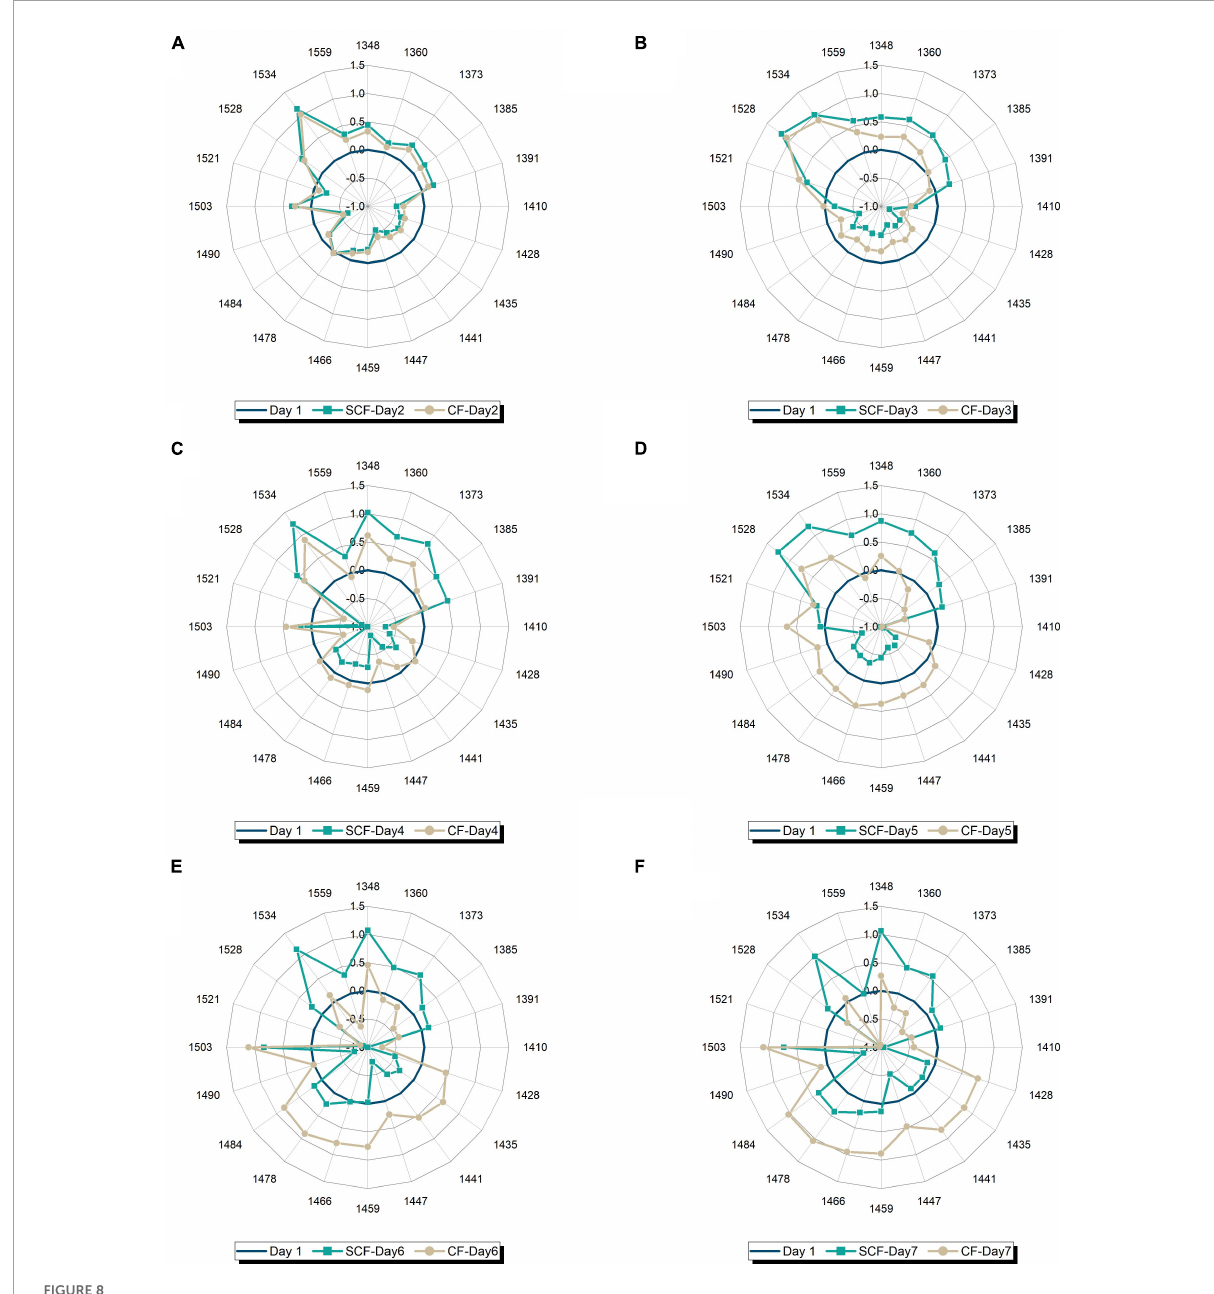
FIGURE8 Comparison of water spectral patterns of strawberries stored in control (CF) and supercooling fridge (SCF) on day-to-day basis: (A) After 1 day of storage, (B) after 2 days of storage, (C) after 3 days of storage, (D) after 4 days of storage, (E) after 5 days of storage, and (F) after 1 week of cold